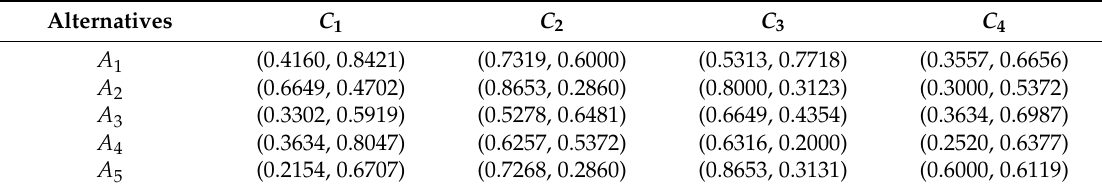
Table 4. The collective decision matrix obtained by the PFWMM operator.